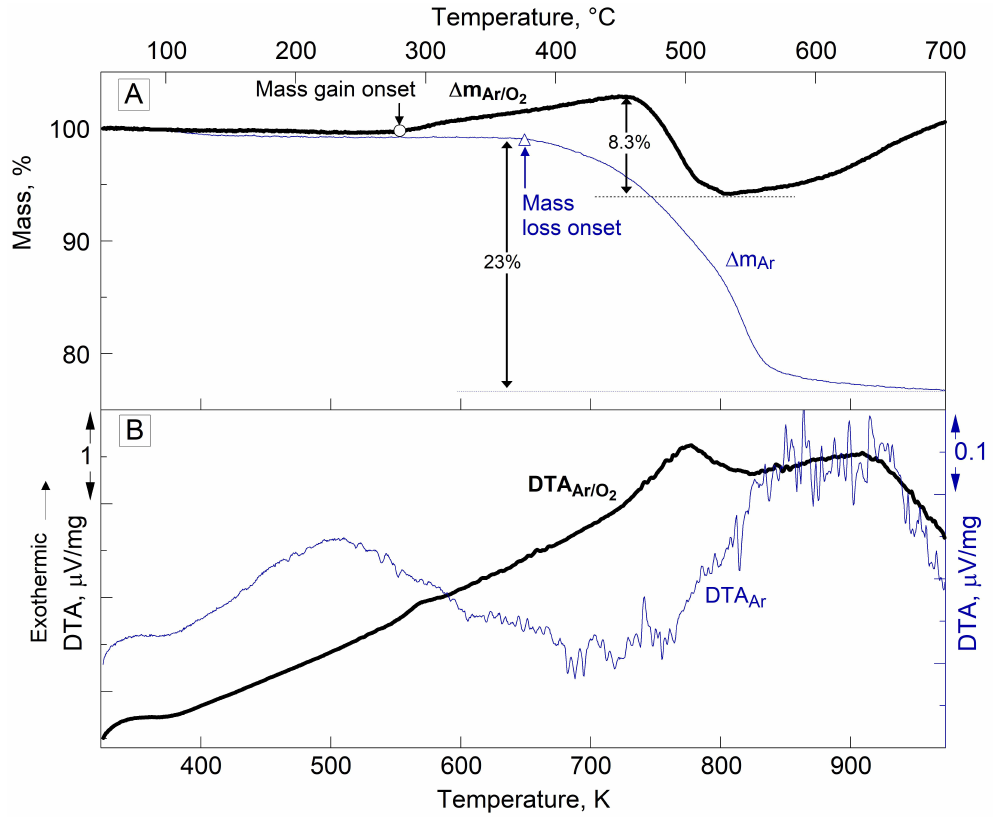
Figure 4. ( A ) Thermogravimetric analysis (TG) and corresponding ( B ) di ff erential thermal analysis (DTA) traces for 50Si · 50CoF 2 heated at 5 K / min in di ff erent environments. For TG in Ar / O 2 , the onset for a gradual mass gain was at 548 K (275 ◦ reversed at 723 K (450 C), and the maximum mass loss of ca. 8.3% was observed by 798 K (525